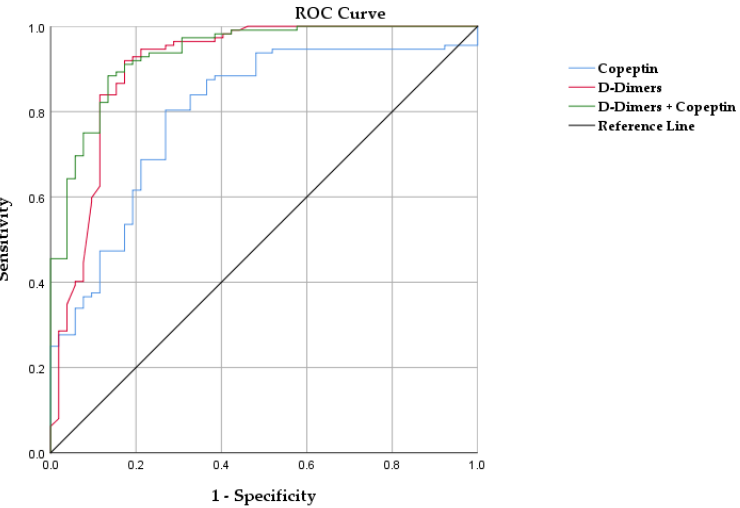
Figure 2. ROC curve analysis of copeptin and D-dimers for PE diagnosis.